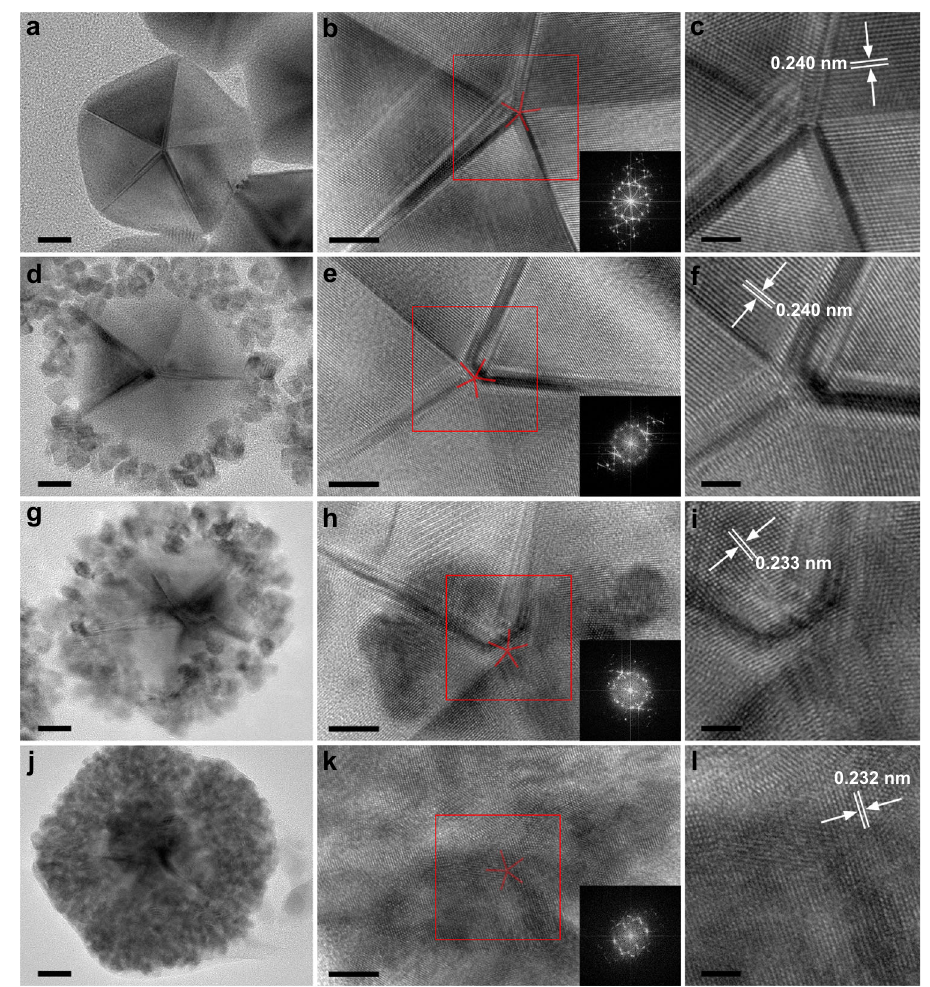
Fig. 2 Surface lattice engineering on AuNDs surface. HRTEM images of AuND@PtNC nanocrystals with different molar ratios of Pt and Au: a , b , c 0; d , e , f 0.5; g , h , i 1; j , k , l 2. The images in c , f , i , l are the areas marked by the red boxes in b , e , h , k and the insets are corresponding FFT patterns. Scale bars in a , d , g , j are 10 nm. Scale bars in b , e , h , k are 5 nm. Scale bars in c , f , i , l are 2